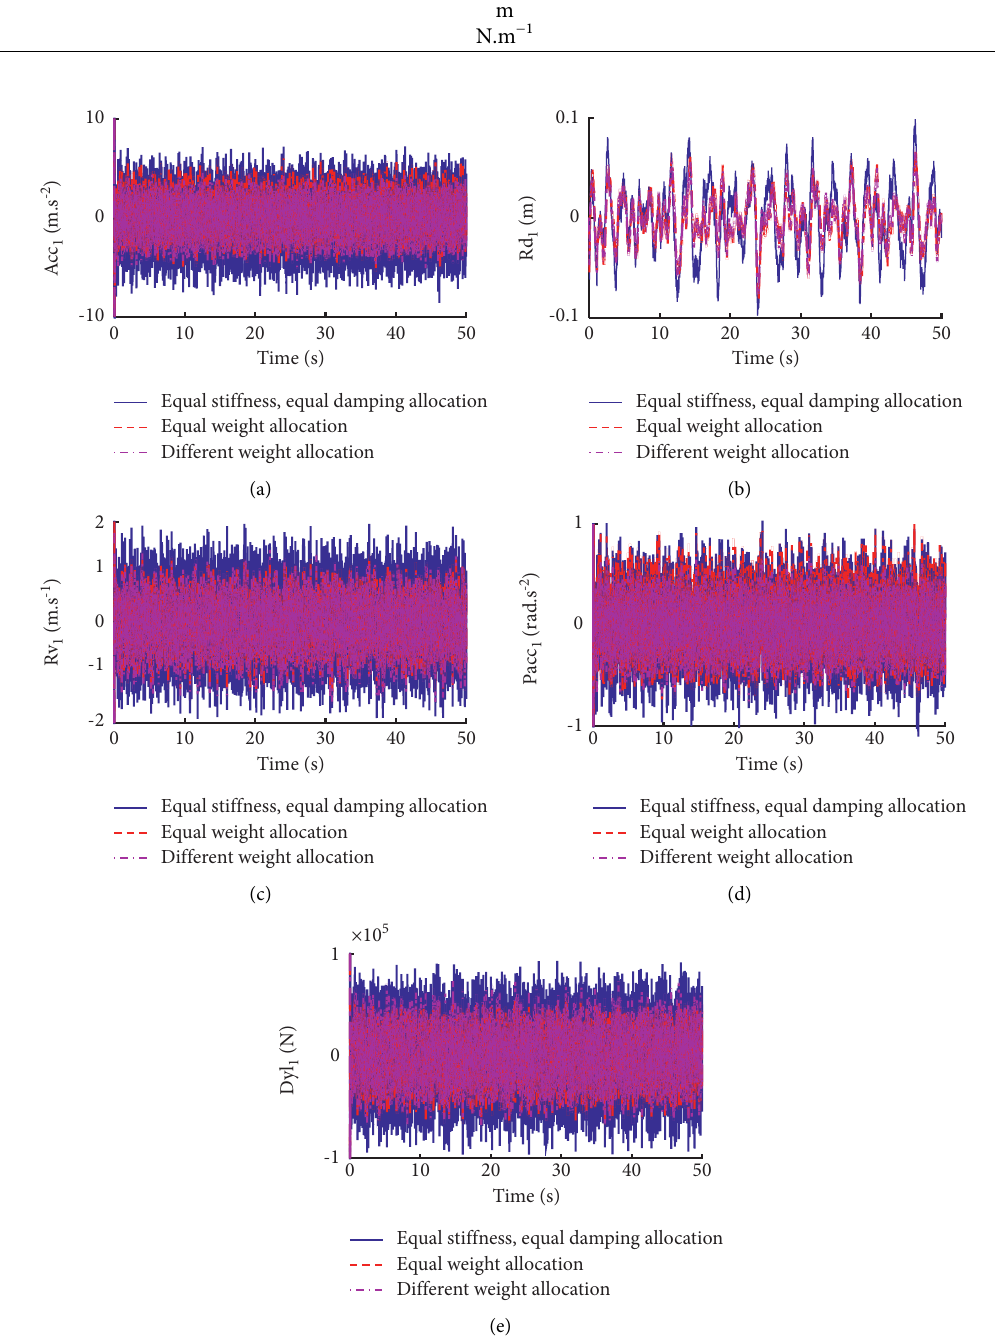
Figure 14: Comparison for the response signals (on Gobi road).